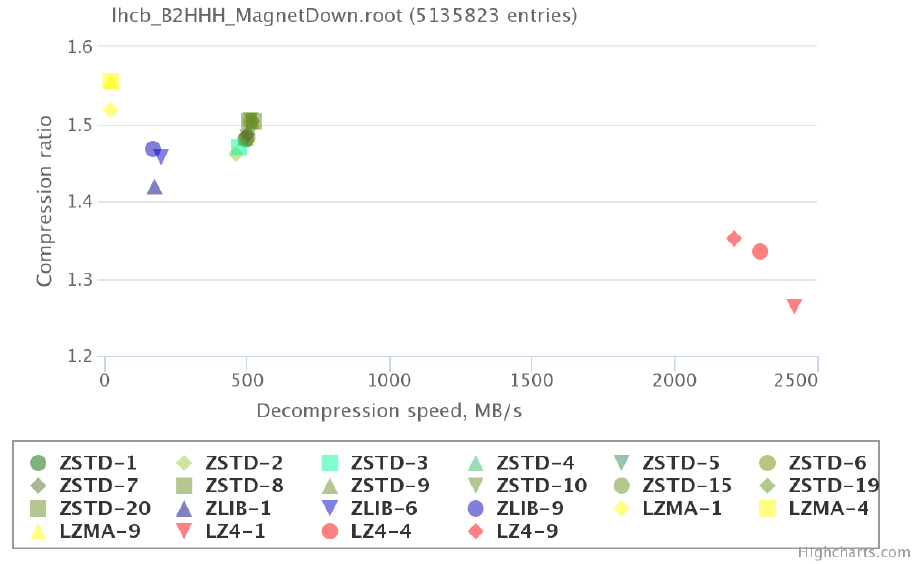
Figure 3. Comparison of compression ratio and decompression speed for all compression algorithms for LHCb